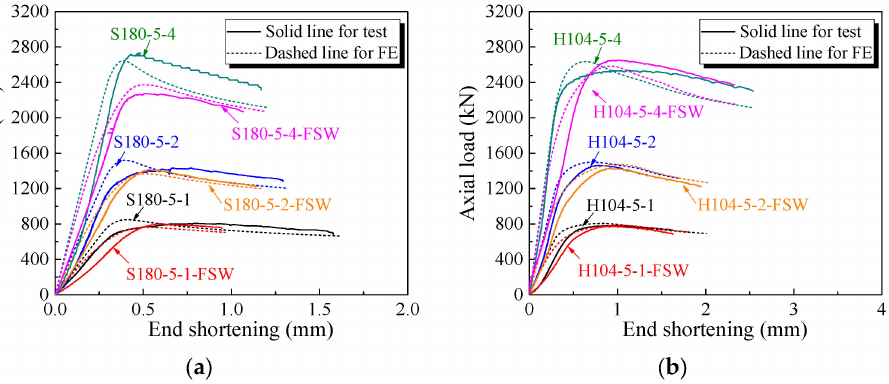
Figure 10. Axial load versus end shortening curves of honeycomb specimens: ( a ) SHS specimens; ( b ) HHS